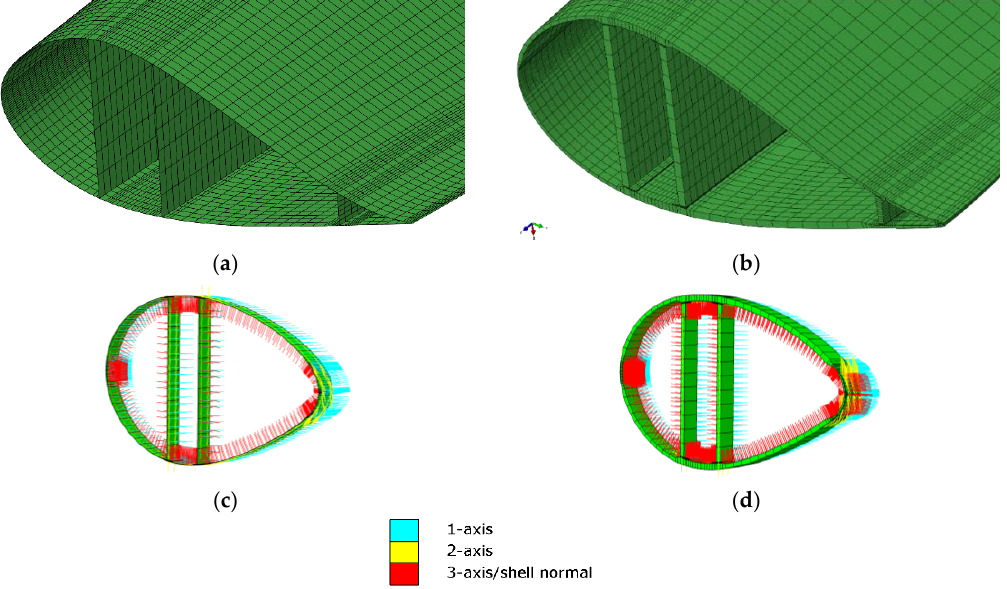
Figure 4. Cross-sections of the different finite element (FE) models. ( a ) Conventional outer mold layer (OML) shell model, consisting of second-order S8R elements; ( b ) model consisting of second-order, layered solid elements, C3D20R; ( c ) slice of the OML shell model showing the local material orientations; ( d ) slice of the solid model showing the local material orientations.